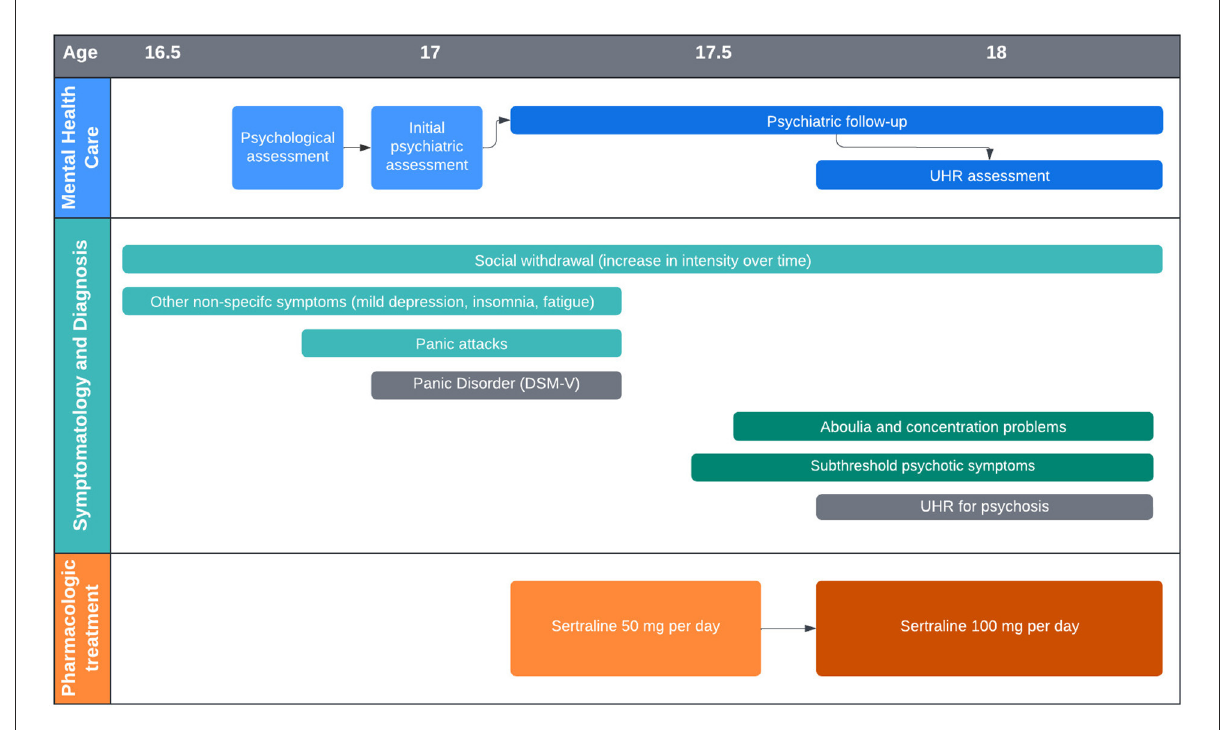
FIGURE1 Simplified timeline of psychiatric symptoms and pharmacologic